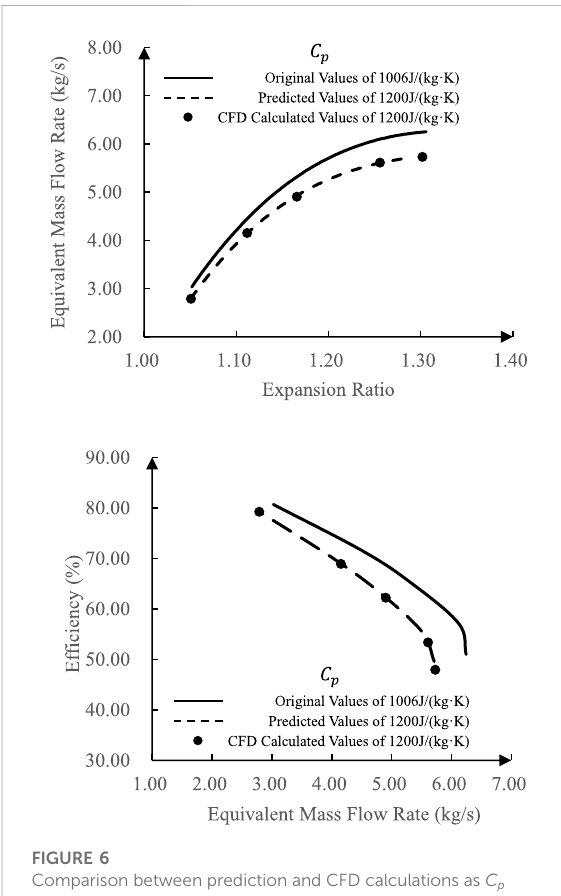
FIGURE 6 Comparison between prediction and CFD calculations as C p evolves in the 1.5-stage turbine. FIGURE 7